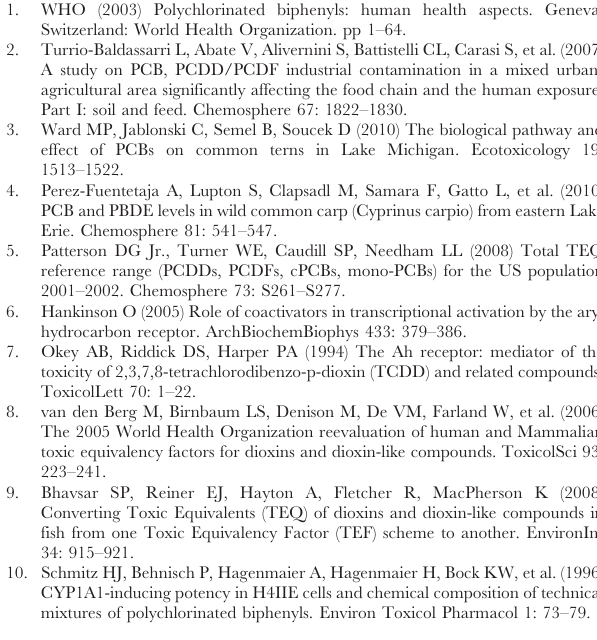
Figure S5 Myricetin dose-dependently suppresses AhR induction, and this effect wanes as [PCB 126] increases. A complete dose-response curve for PCB 126 is presented, although myricetin (10 m M and 25 m M) was only tested against pre-determined concentrations of PCB 126 (0, 5 nM, 10 nM, and 20 nM; 25 m M myricetin was always tested against 100 nM PCB 126 as a negative control for myricetin efficacy. *p , 0.05 for myricetin effect vs. respective no-myricetin PCB condition. Data are average of 2–3 experiments; error bars are 2 / + SD. Figure S6 Standard least squares analysis of CYP1A1 activation versus PEPCK induction. PCBs 126, 169, 81, and 77 at 20, 100, and 500 nM were compared with respect to their activation of CYP1A1 gene expression (x-axis) and inhibition of PEPCK gene induction (y-axis). Standard least squares linear regression revealed statistically significant relationship between magnitude of CYP1A1 induction and PEPCK suppression (p , 0.05). Data are derived from experiments performed for figure 6. Error bars have been excluded for clarity. Table S1 qRT-PCR primer sequences and expected amplicon